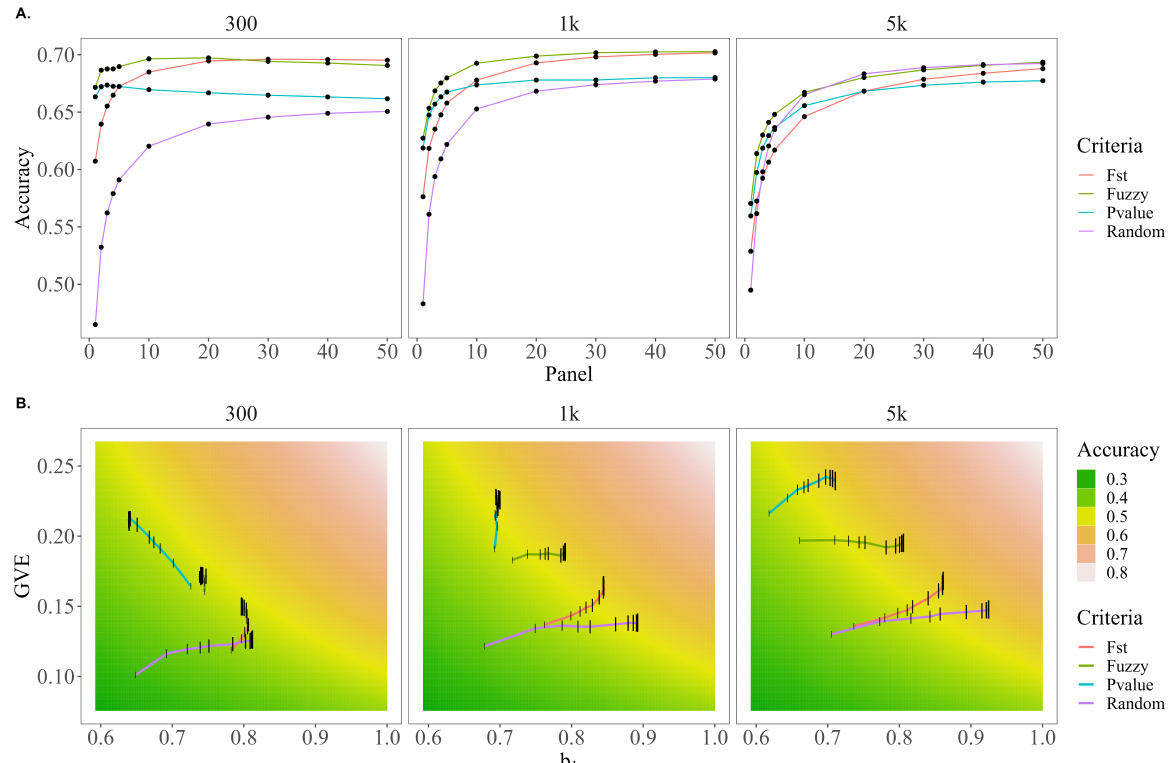
Figure 4. Trends in accuracy, dispersion, and variance of EBVs for random, F ST score, p -value, or fuzzy score preselection when only 14 of 29 chromosomes harbor causative variants under genetic architectures of 100, 1 k, and 5 k QTL. ( A ) The trends in accuracy for random, F ST , p -value, or fuzzy score preselected panel sizes of 1–50 k SNPs. ( B ) A comparison of how the bias of EBVs ( b 1 , x -axis) and genetic variance captured by EBVs (var(ˆ u ), y -axis) for random, F ST , p -value, or fuzzy score preselected panel sizes of 1–50 k SNPs (panel size reflected by height of black bar) move through the parameter space of the genomic prediction accuracy (cor( u ,ˆ u ), gradient